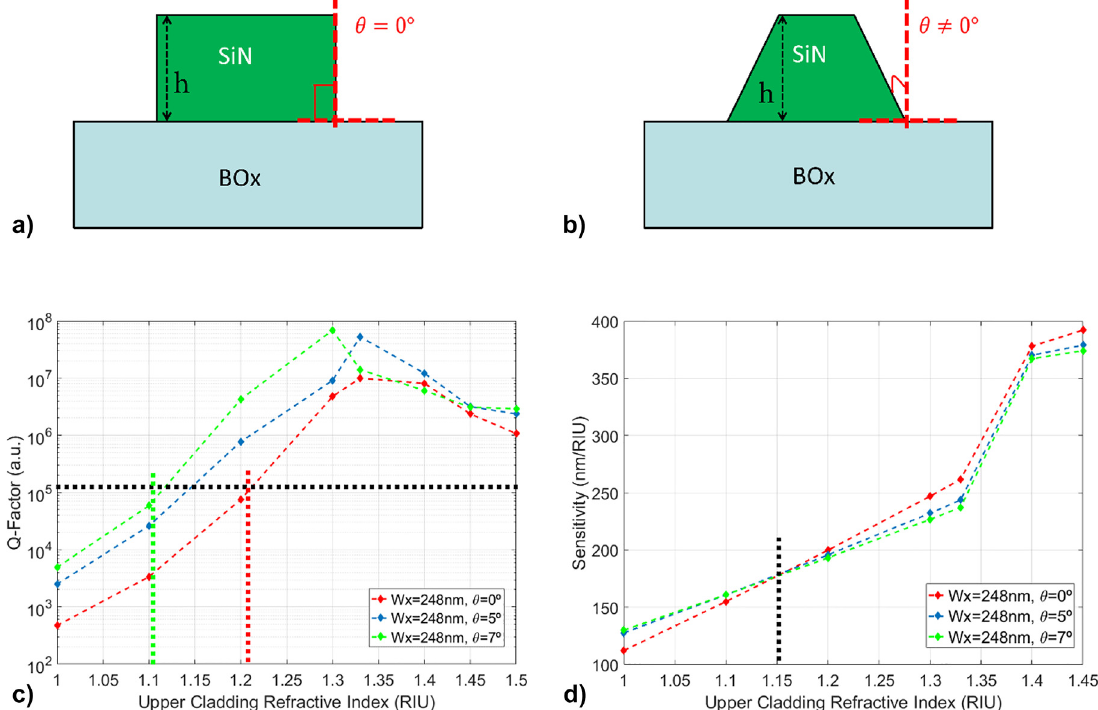
Figure 4: PhC cavity sidewall angle design, (a) and (b) Schematics of the 1D PhC cavity sticks illustrating different sidewall angles. The upper base of the trapezoid has the same size of the rectangular stick base. (c) Calculated Q-factor trends with varying upper-cladding refractive index for constant stick width of 248 nm and different sidewall angle values (0 ◦ , 5 ◦ and 7 ◦ ). The red and green dashed lines refer to lowest refractive index with a Q-factor equal to 10 5 (black dashed line). (d) Sensitivity against upper-cladding refractive index of the 1D PhC cavity for the same sidewall angle values in